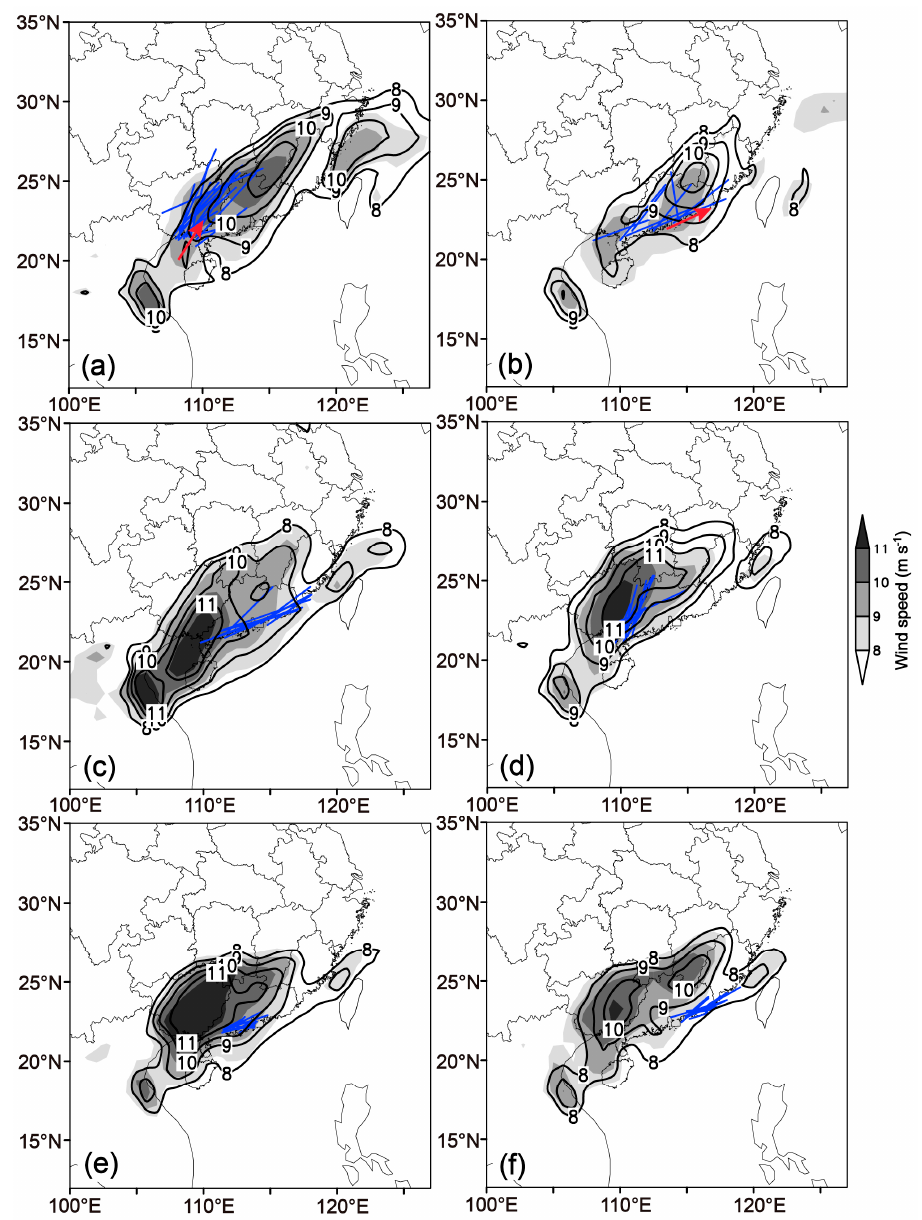
Figure 9. Composite evolution of LLJs for the OWSRs in the SWLLJ situation which occur in the coastal areas of ( a ) GX Province and ( b , c ) GD Province with a long extension and in the coastal areas of ( d ) BGG, ( e ) YJ city, and ( f ) SW city with a short extension. The gray-shadeing and contours indicate wind speeds (units: m s − 1 ) at 850 hPa near the initial time of OWSR and 6 h after the initial time, respectively. The blue lines indicate the axes of the OWSRs, and the arrows in ( a ) and ( b ) indicate the movement directions of LLJ.